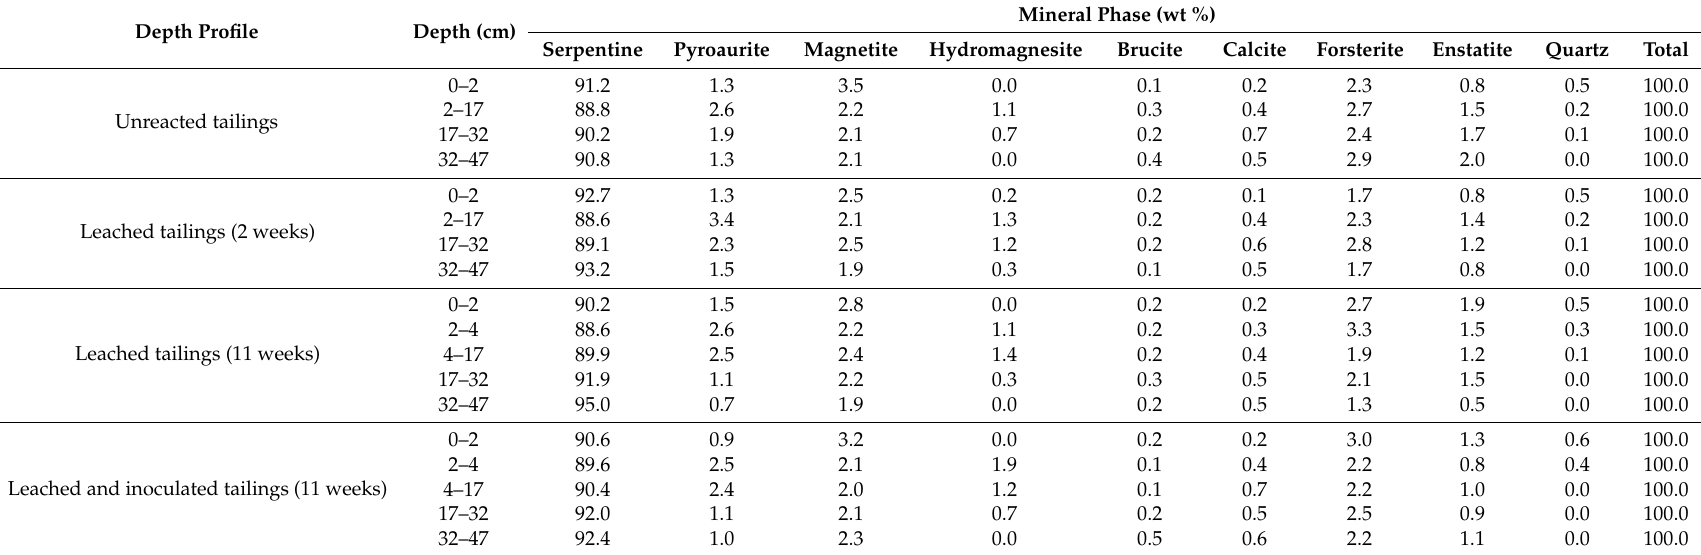
Table 1. Rietveld results for the tailings sampled over the duration of the carbonation trial. Each value is given as an average of triplicate samples. The full dataset and corresponding R wp values are available in the supplementary information file (Supplementary Materials Tables